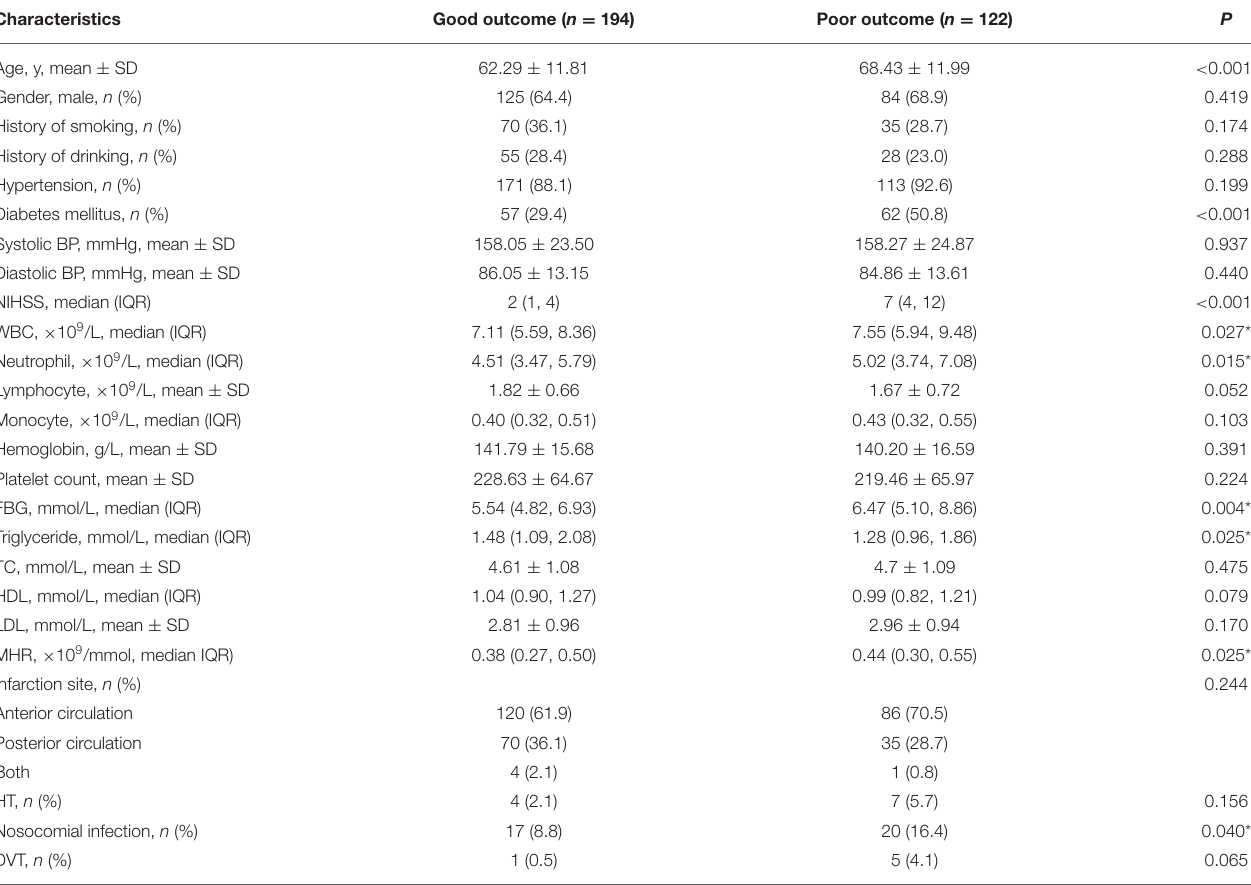
TABLE 1 | Baseline characteristics of the study population in relation to 3-month outcome. Characteristics